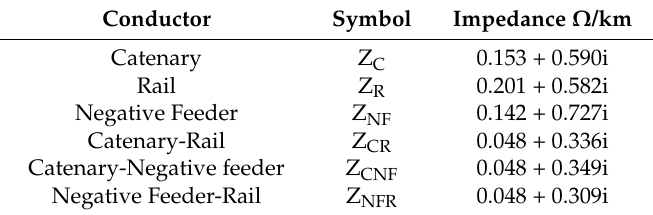
Figure 12. Simplified diagram of the spatial structure of all parallel AT TPSS. Table 2. Self and mutual impedances values per length unit of all parallel AT TPSS.